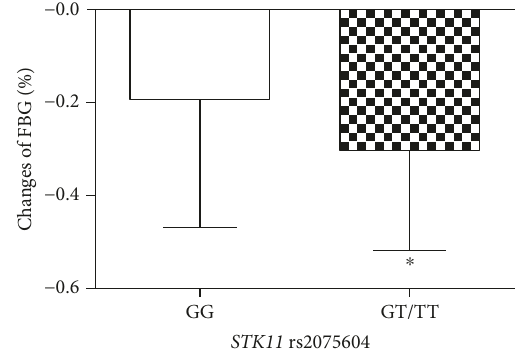
Figure 2: The decreased level of FBG in T2DM patients with di ff erent STK11 rs2075604 genotypes after metformin treatment. Data are shown as mean ± SD. ∗ P < 0 05 compared with the GG genotype group ( n = 94